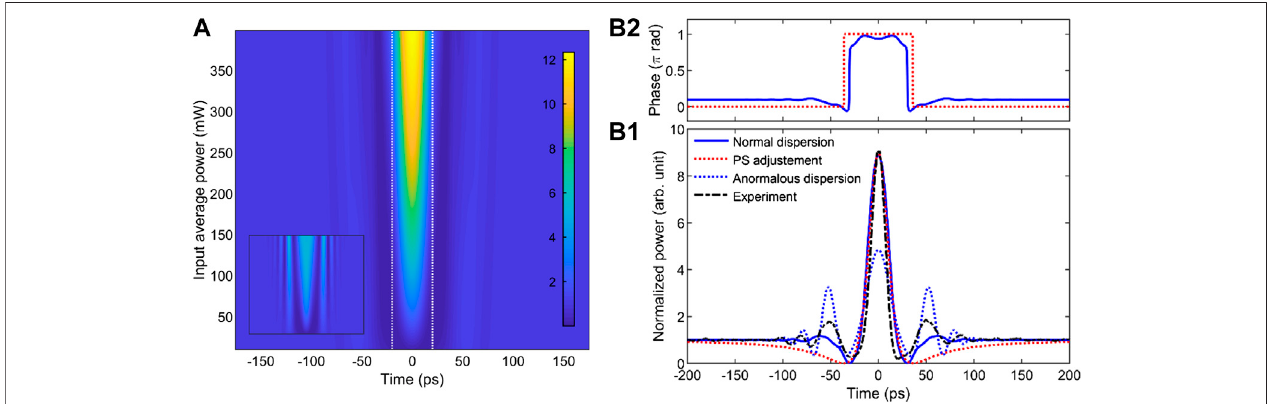
FIGURE 4 | (A) Numerical simulations of the output temporal intensity pro fi les based on the NLSE including power-dependent losses due to Brillouin backscattering. Intensity pro fi les are normalized by the intensity of the output continuous background. Inset shows the results obtained in a virtual fi ber with opposite dispersion. (B) .Detailsofthetemporalintensityandphasepro fi les(panel (B1) and (B2) ,respectively)obtainedforaninputpowerof23 dBm:numericalsimulationsofthe propagationinthe fi berwithnormaldispersion(blueline,nonlinearlossesincluded)arecomparedwitha fi twithaPSwaveform(dottedredline).Thebluedottedline represents the results predicted with a virtual anomalously dispersive fi ber (nonlinear losses included). The mixed black line recalls the experimental